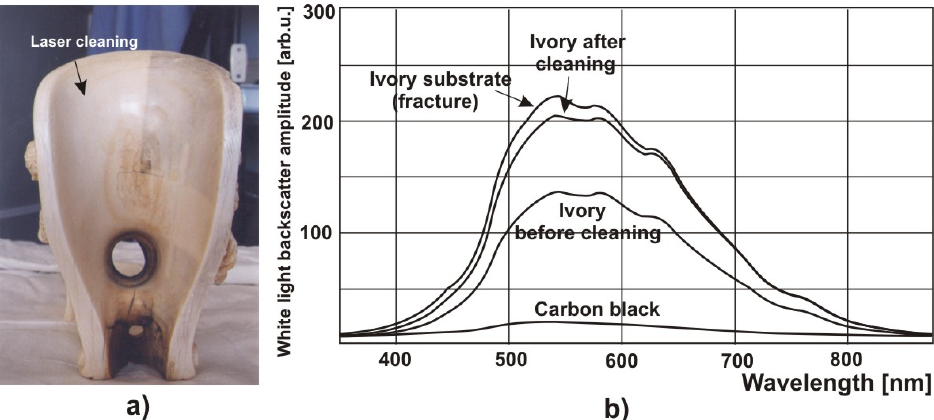
Figure 36. Results of measurements of light amplitude scattered from an ivory artwork: a) photograph of internal surface of ivory pitcher; b) experimental results.